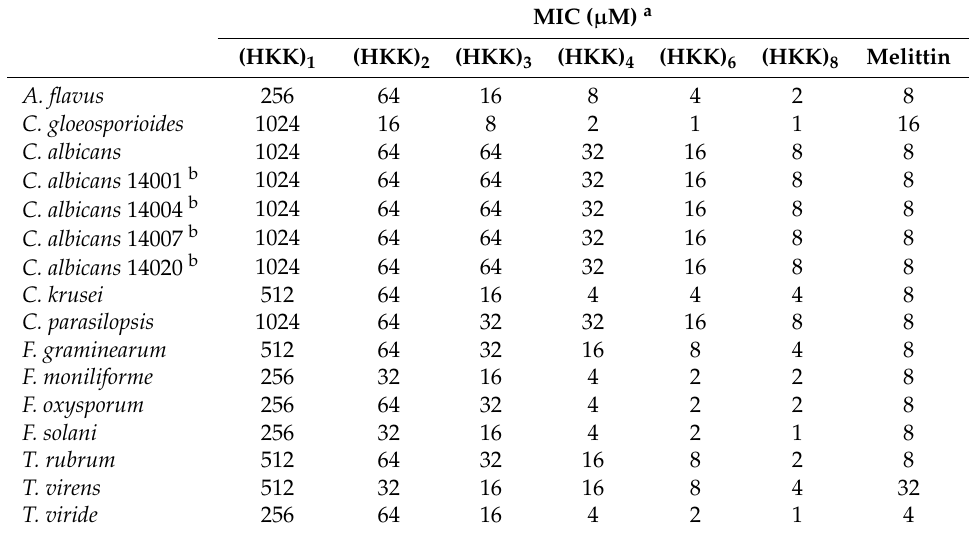
Table 1. Antifungal activity of histidine-lysine-lysine (HKK) peptides against pathogenic